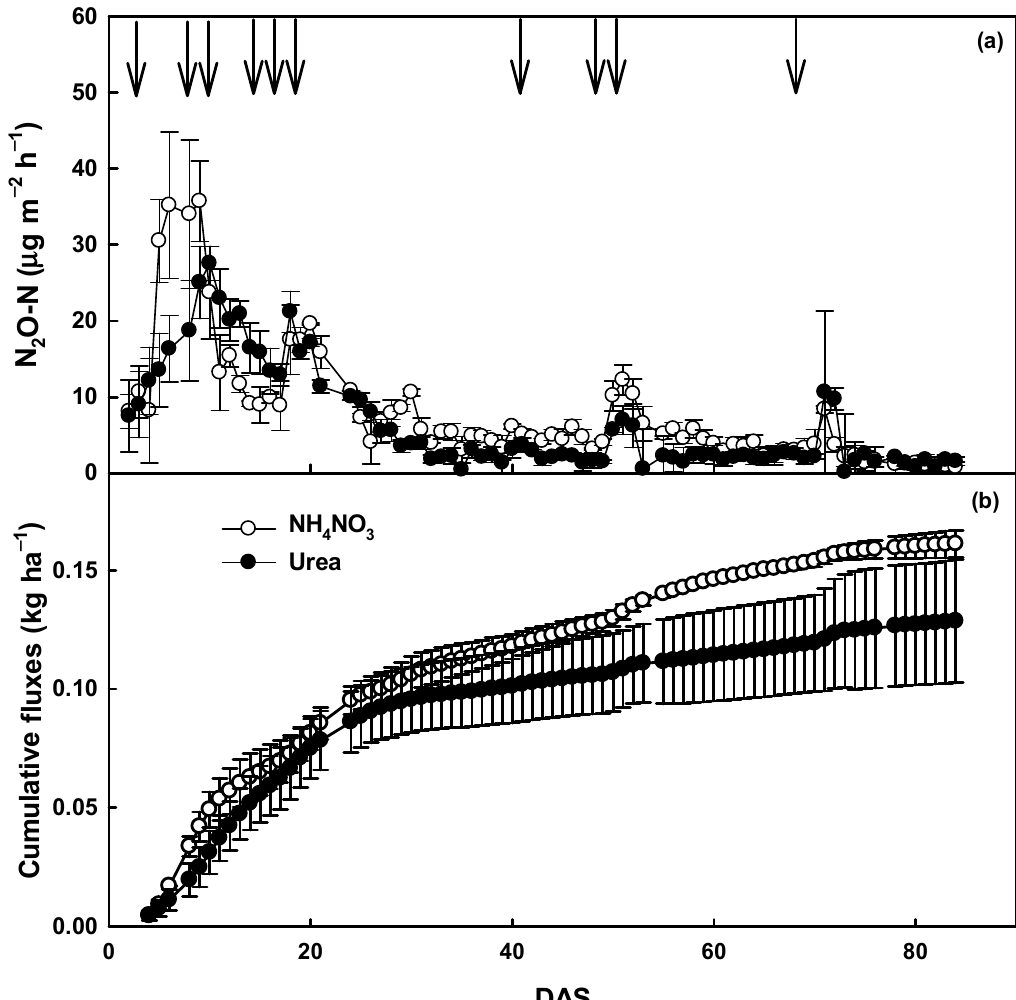
Figure 5. ( a ) Soil Nitrous oxide (N 2 O-N) fluxes and ( b ) cumulative nitrous oxide (N 2 O-N) from plots fertilized by ammonium nitrate (open circles) and urea (filled circles). The arrows denote irrigation events. Data are means ( n = 4) ± SE.